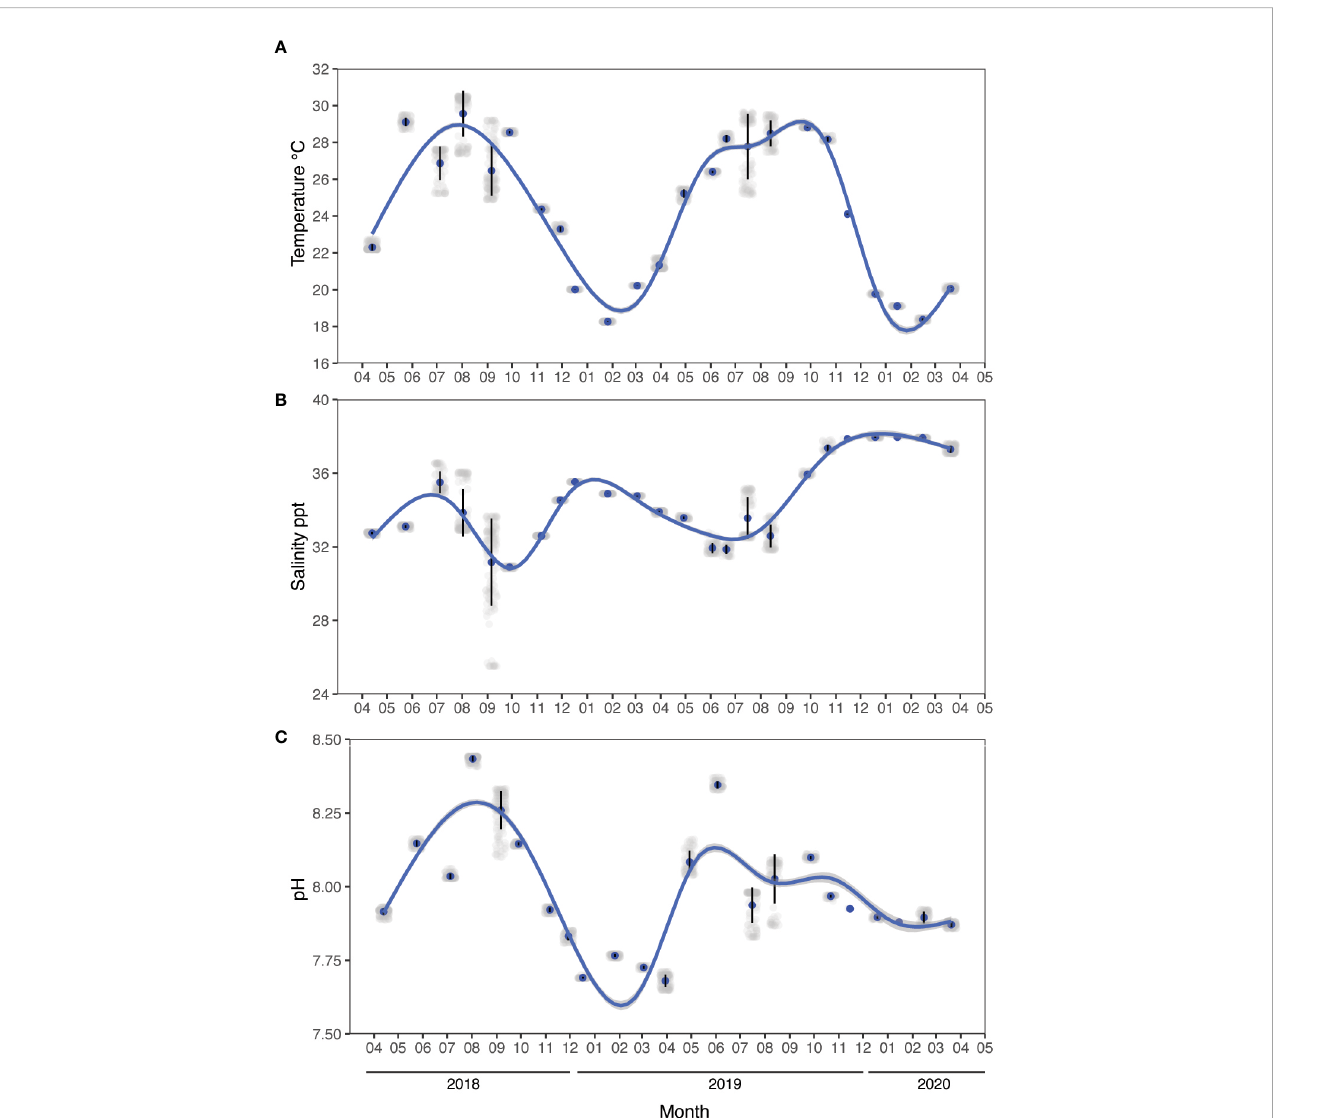
FIGURE 2 Environmental parameters measured in situ between April 2018 and March 2020. (A) Temperature, (B) salinity, and (C) pH. Data were recorded every month using a YSI multi-parameter sonde during daytime hours (between 10:30 am to 1:30 pm). Noise is added (jittering) for data visualization, the vertical lines indicate the standard error, and the blue line indicates a generalized additive model fi t